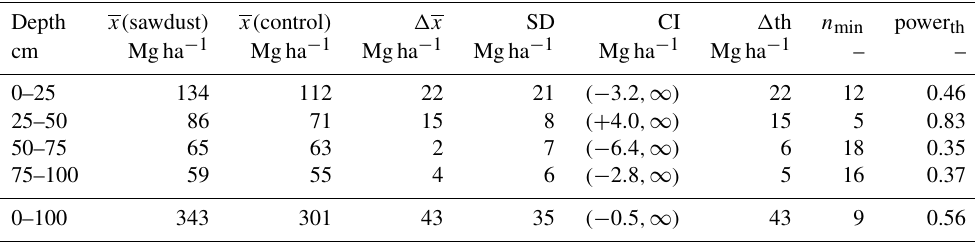
Table A2. The means of the OC stocks ( x (sawdust), x (control)), their differences ( (cid:49)x ), and their pooled standard deviation (SD) are pre- sented. The confidence interval (CI) is calculated from a t test (one sided, significance level α = 0 . 05, power 1 − β = 0 . 8, sample size 5, unpaired) to answer the alternative hypothesis that x( sawdust ) − x( control ) is larger than zero. The difference is significantly larger if the CI is >0. We also calculated the minimum sample size ( n min ) and power (power th ) for a theoretical difference ( (cid:49) th) between the sites to evaluate the power of our data. The (cid:49) th is either taken from (cid:49)x or assumed to be 10% of x( control ) .